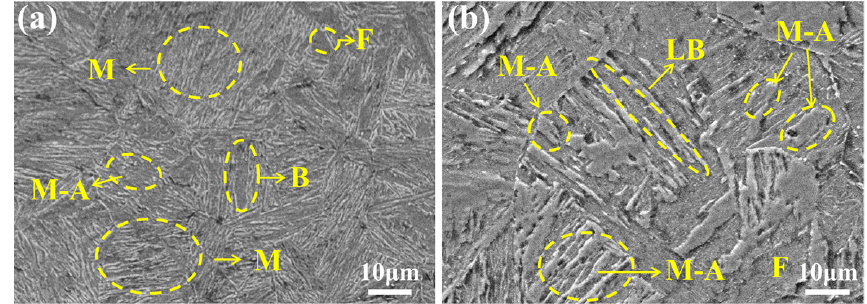
Figure 6. Microstructure (SEM) at ( a ) t 8/5 = 4 s and ( b ) t 8/5 = 18 s when T max = 1250 °C.